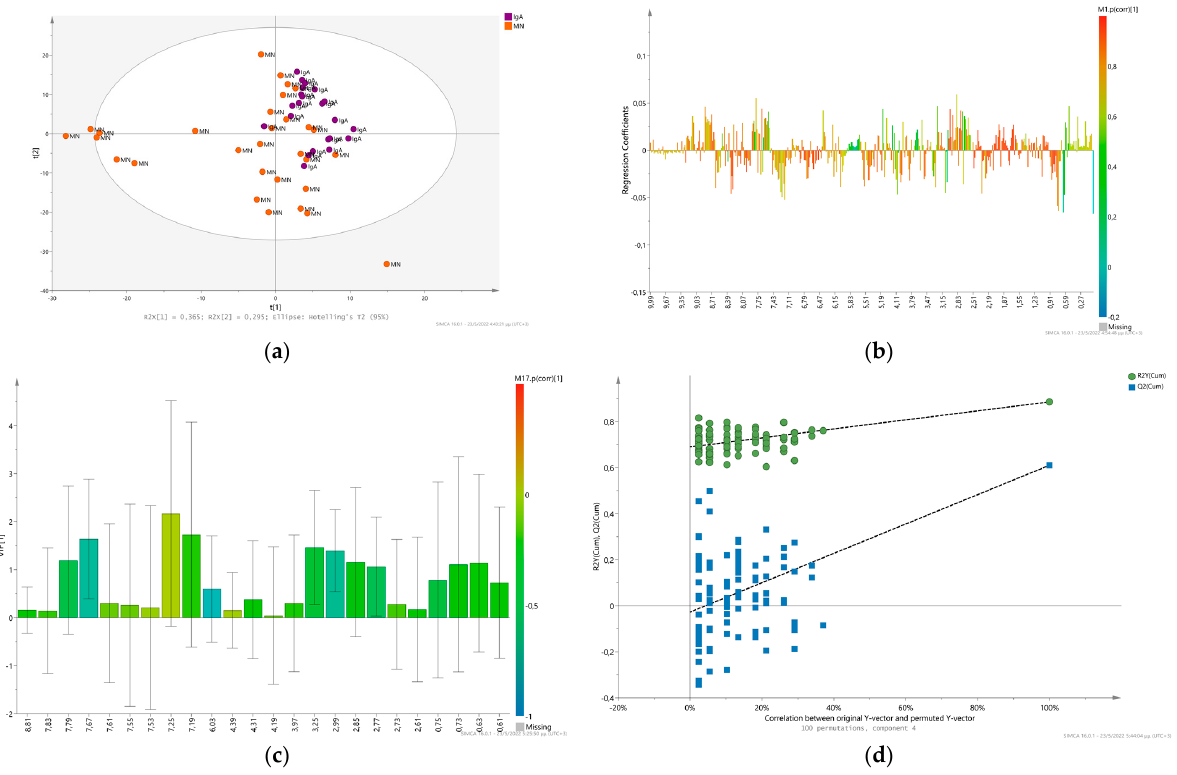
Figure 1. Multivariate analysis of 1 H 1D NMR urine spectra of patients with the two highly occurring etiologies, IgAN (purple spheres) and MN (orange spheres). ( a ) PLS-DA scores plot of the IgAN and MN glomerulonephritis. ( b ) PLS-DA Coefficients’ plot of the comparison between the CPMG urine spectral data of IgAN and MN glomerulonephritis. ( c ) PLS-DA VIP scores first 25 in sort descending order of urine glomerulonephritis metabolomes colored according to their presenting correlation and contribution coefficients “p(corr)” at the first latent component VIP [1]. ( d ) Permutation plot of the PLS-DA model validating the statistical significance of the model as the permuted R 2 (green cycles) and Q 2 (blue squares) are lower than the original values of R 2 and Q 2